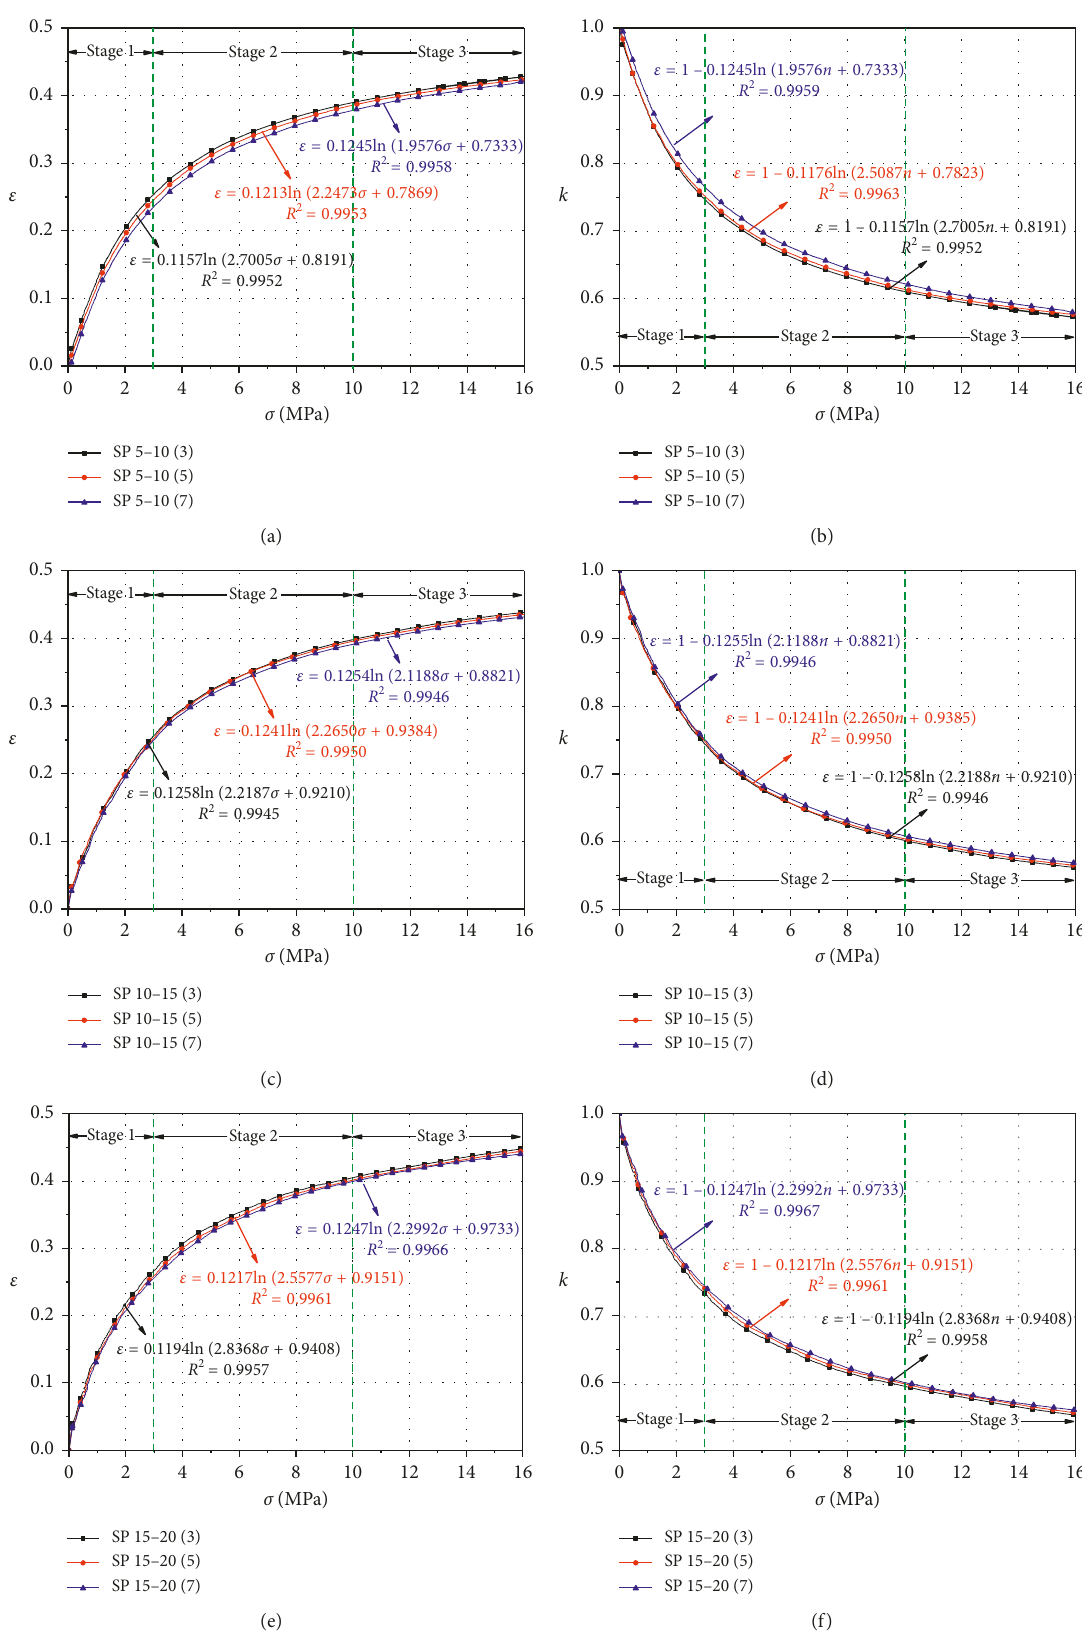
Figure 7: Compaction characteristics of coal gangue with identical particle size at three levels of pH. (a) 5–10mm: σ – ε ; (b) 5–10mm: σ – k